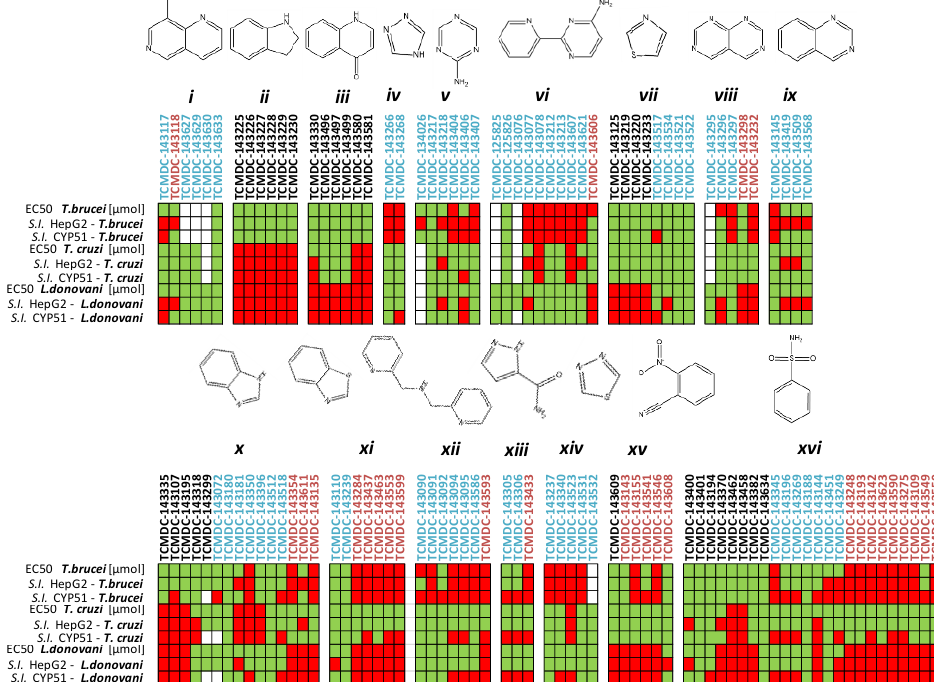
Figure 3. Inhibition growth rate and early toxicological data of the compounds belonging to the 16 clusters identified by similarity-based analysis as the most representative of the entire Kinetobox. The data ranges are reported using a traffic light system. EC 50 values for T. brucei , L. major and T. cruzi and selectivity index ( S.I. ) with respect to CYP450 and HepG2 cells are reported. The cells are green colored when the EC50 vs Tc/Ld/Tb parasites is >10 µM, S.I. HepG2 and S.I. CYP51 ≥ 10 , and red when data indicate no activity and toxicity (EC 50 vs Tc/Ld/Tb proteins ≥ 10 μM, S.I. HepG2 and CYP51 > 10). * White corresponds to “no data available”. Compound label s: black, HAT-box compounds ( T. brucei ); cyan, LEISH-box compounds ( L. donovani ); magenta, CHAGAS-box compounds ( T. cruzi ).